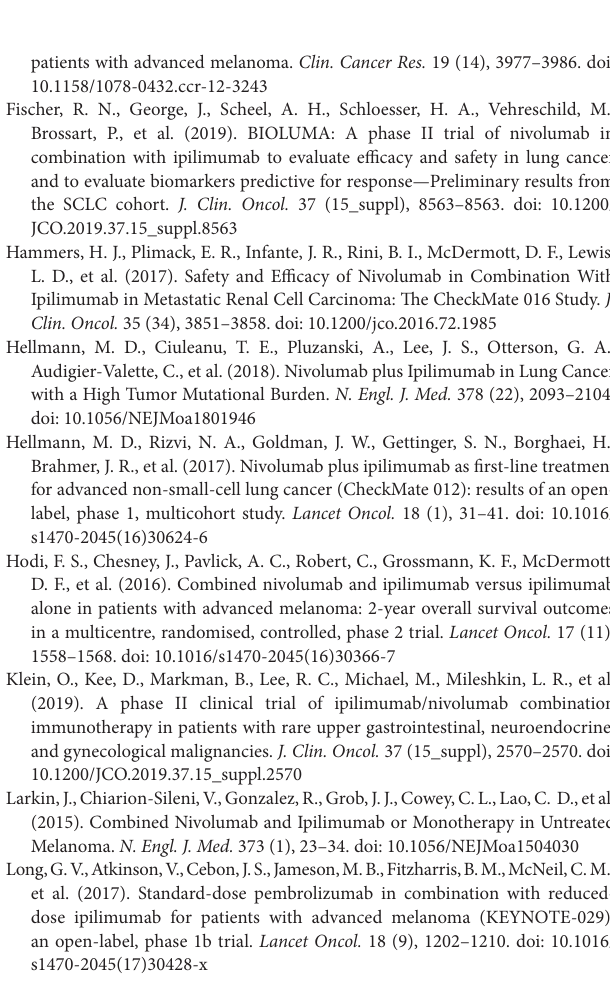
SUPPLeMeNTARy FIGURe 1 | Funnel Plots for studies included in the meta- analysis for objective response rate (ORR), grade 3–4 adverse events (AEs) and fatal adverse events